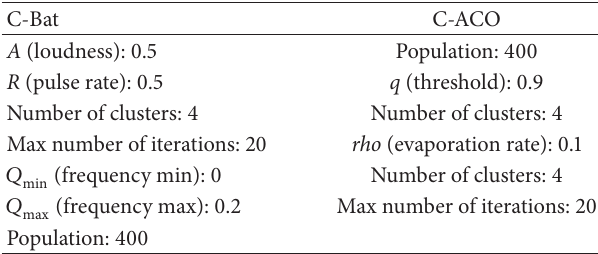
Table 6: Parameters set for C-Bat and C-ACO.